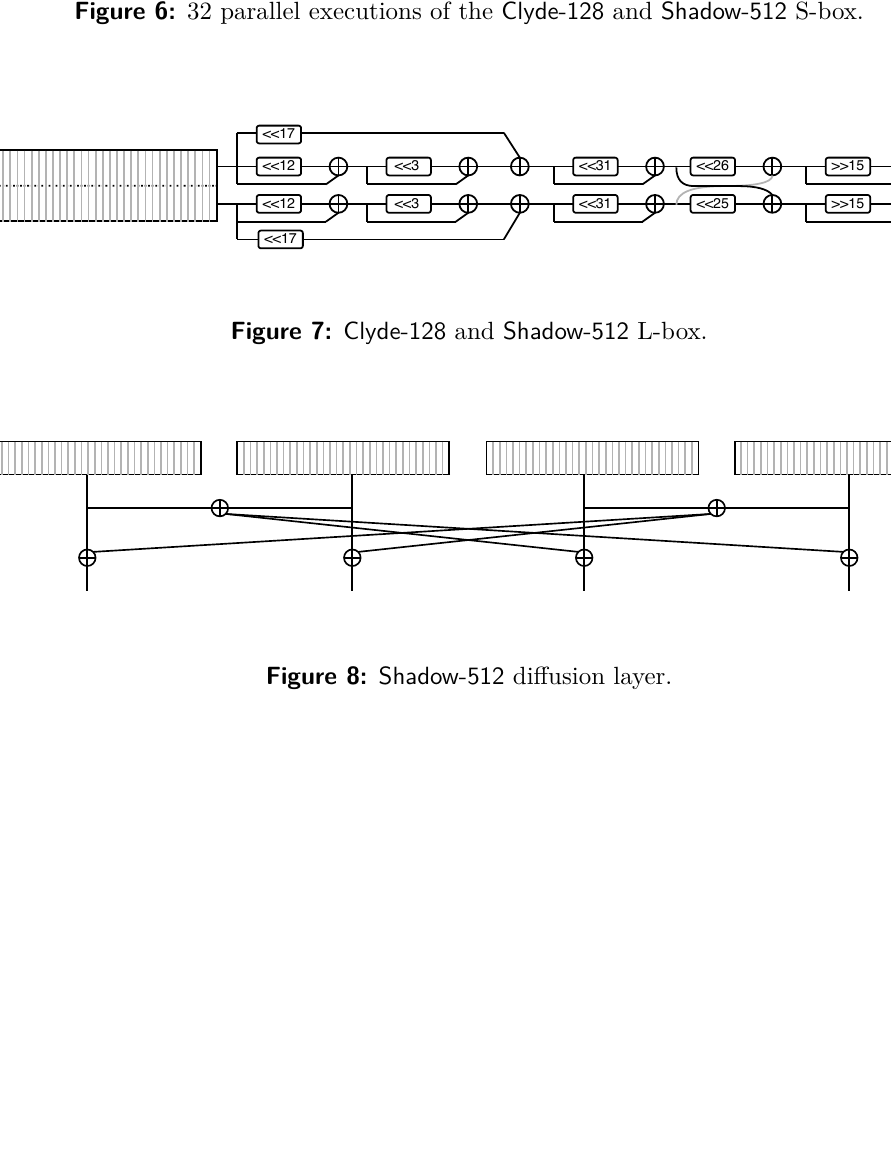
Figure 6: 32 parallel executions of the Clyde-128 and Shadow-512 S-box.